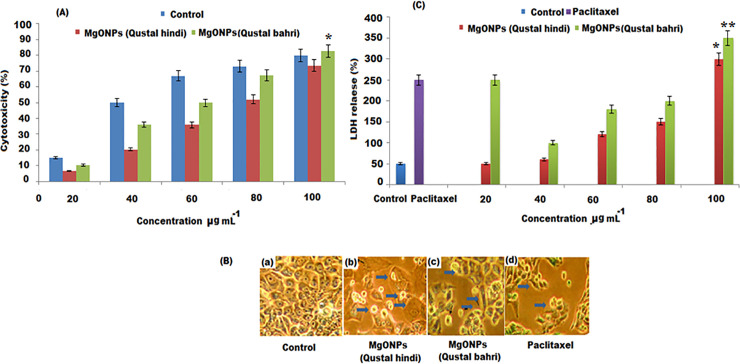
Anticancer effect of MgONPs on MCF-7 cells (A) MTT analysis to estimate the cytotoxicity (B) LHD assay to detect the membrane integrity and (C) microscopic images describing morphological changes.